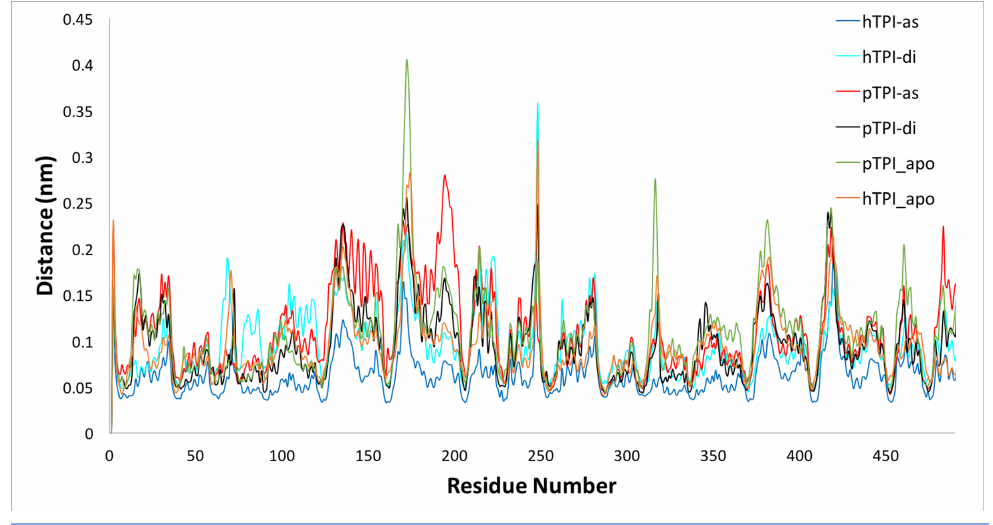
Figure 5 Root-mean-square fl uctuations of hTPI and pTPI complexes with sulfaE. Residues 1 – 248 correspond to chain A and residues 249 – 496 chain B.